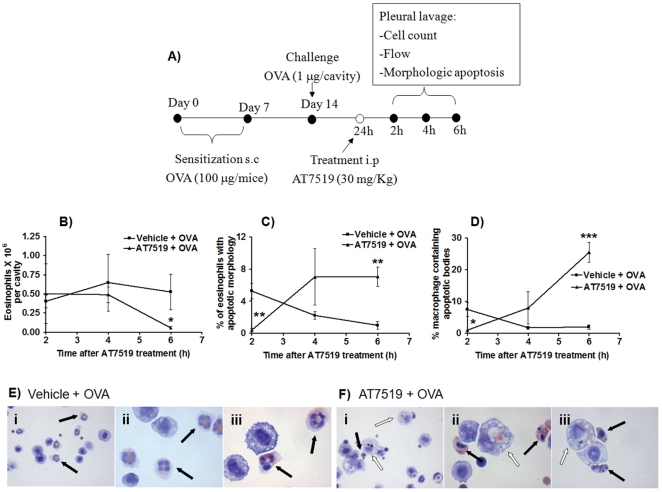
AT7519 drives eosinophil apoptosis and subsequent clearance by macrophages as assessed by morphological analysis.(A) Schematic representation of the experimental protocol. Immunized mice were challenged with OVA and 24 h later received AT7519 or vehicle. Eosinophil number (B), percentage of apoptotic eosinophils (C) and percentage of macrophages containing apoptotic bodies (D) were assed 2, 4 and 6 h after AT7519 treatment. Results are expressed as the mean ± SEM of at least five mice in each group. (B-D) *P<0.05, **P<0.01, ***P<0.001 when compared with vehicle-treated, OVA-injected mice. Representative images from vehicle (E) and AT7519 treated (F) animals are shown (Magnification x400 (i) and x1000 (ii and iii)). In vehicle treated animals (E), black arrows indicate healthy, viable eosinophils while in AT7519-treated animals (F), black arrows indicate typically apoptotic eosinophils and white arrows apoptotic cells inside macrophages.